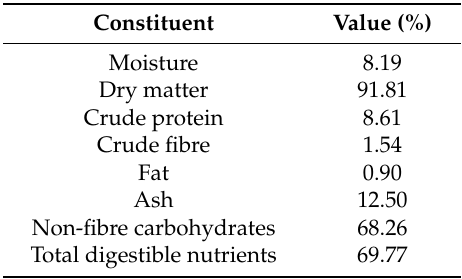
Table 1. Proximate analysis of ginseng berry